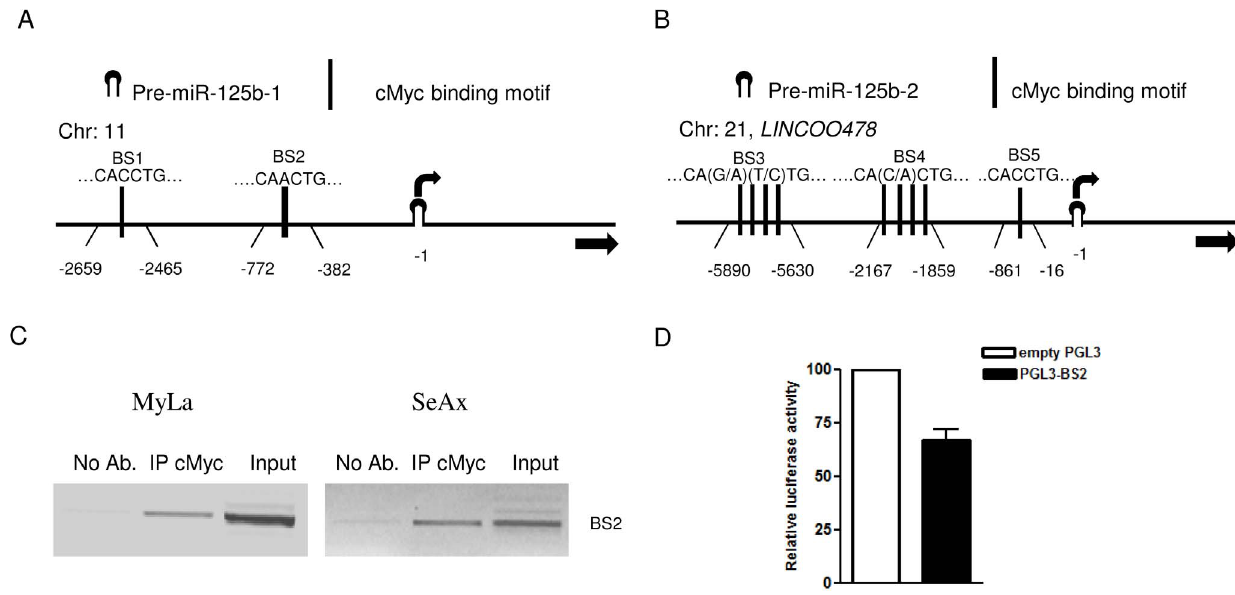
Figure 3. cMyc is a transcriptional repressor of miR-125b-5p. (A, B) Schematic representation of the predicted cMyc binding motifs (black segments) in the region 10 kb upstream of the pre-miR-125b-1 (A) and pre-miR-125b-2 (B) 5 9 terminus (indicated as 2 1). The numbers indicate the amplicon positions relative to the 5 9 terminus of pre-miR-125b-1 and pre-miR-125b-2. (C) ChIP assay on the BS2 fragment. Cross-linked chromatin was precipitated from SeAx and MyLa cells using cMyc antibody. (D) Luciferase activity (measured 48h after transfection) of the pGL3-promoter reporter construct containing the BS2 fragment compared to the empty construct in Hek-293 cells. The relative Firefly luciferase activity is showed after normalization to internal control Renilla luciferase and pGL3-promoter empty vector. Data are presented as mean 6